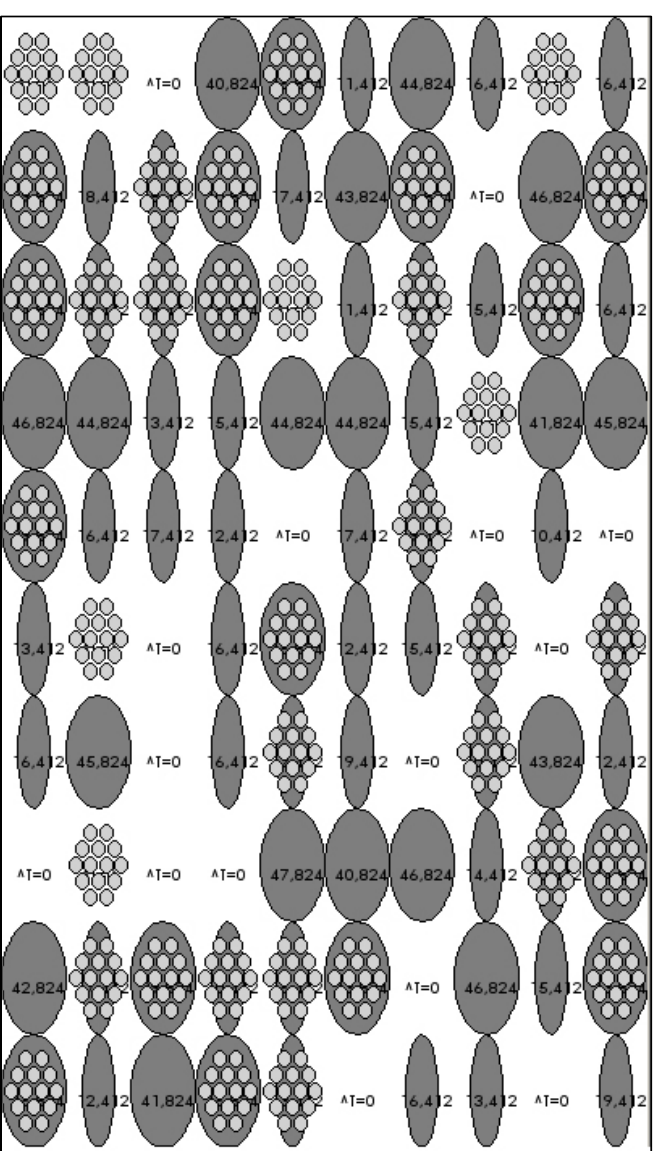
Figure 13. Initial tests results with tournament selection implementation.